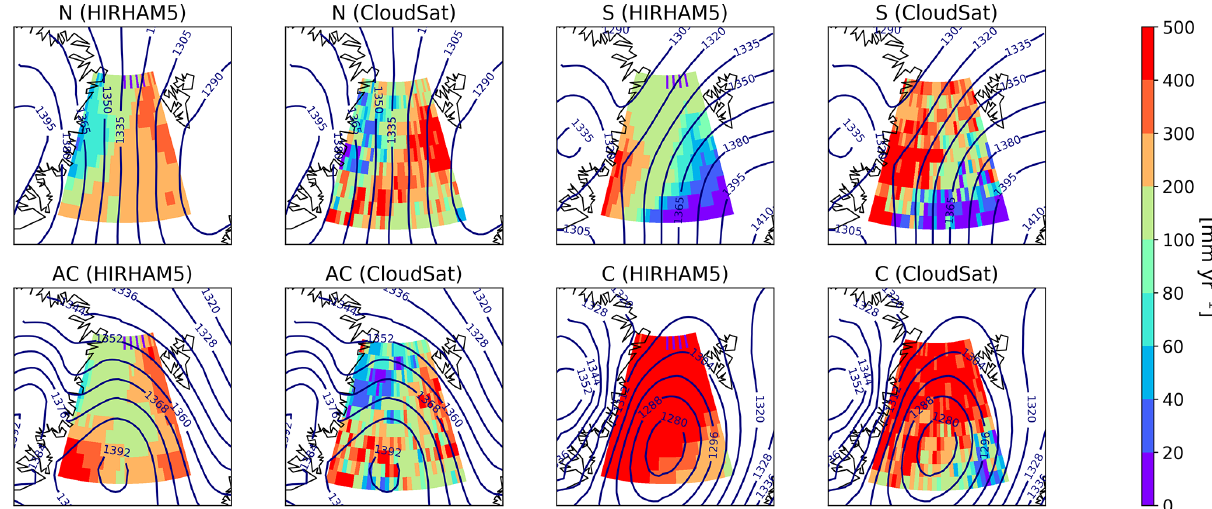
Figure A6. Snowfall rate composited to different CWTs, N (including N, NE, and NW), S (S, SE, and SW), C and AC, for the area of 20–10 ◦ E between latitude bands of 70–81 ◦ N for both HIRHAM5 and CloudSat (the colored sub-region is according to Fig. 3d). The mean 850hPa geopotential height (gpdm) associated with the CWTs is also shown as blue contour lines.